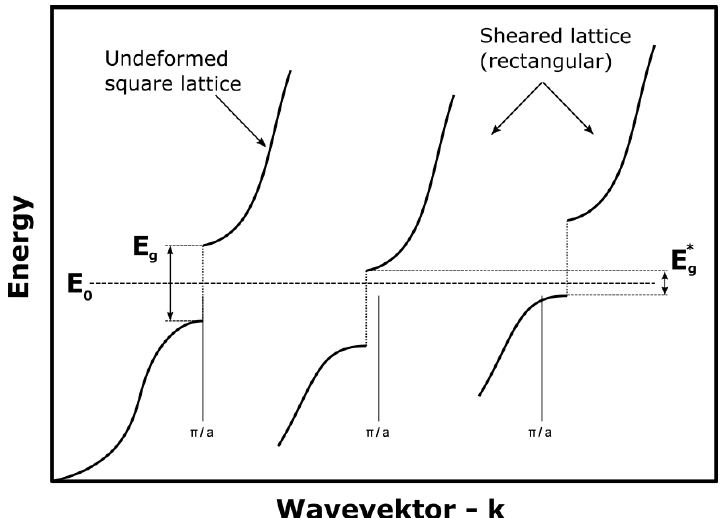
Figure 19. The influence of shear rate onto wave vectors. Shown is the energy vs. wavevector for a simple cubic lattice. Adapted from